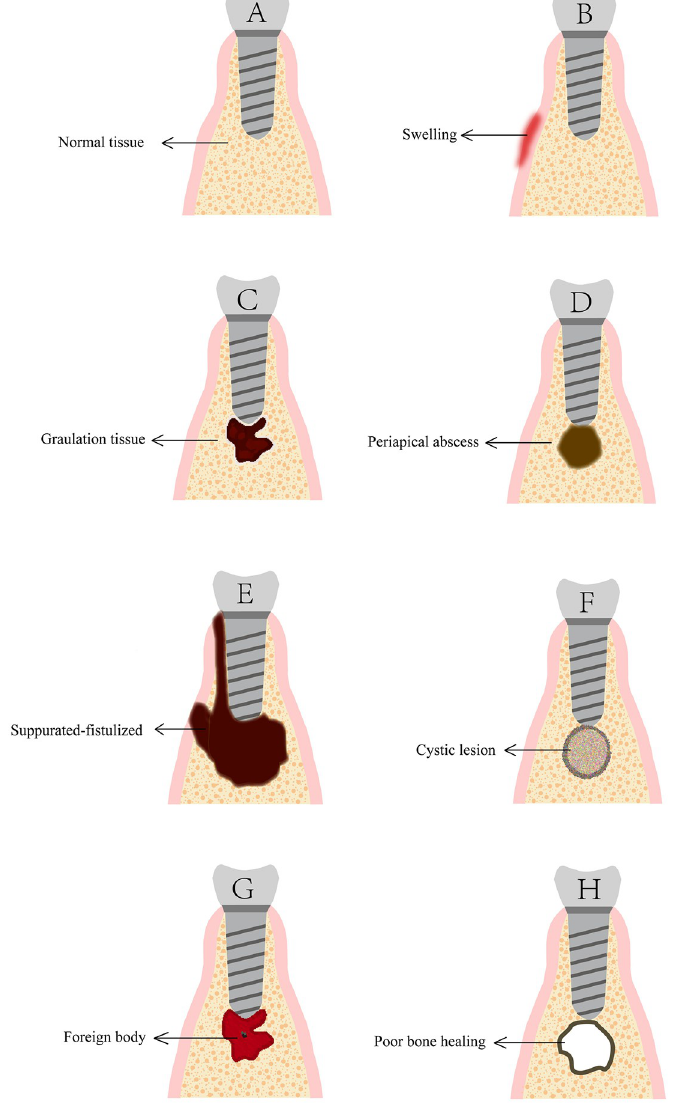
Fig 2. Schematic representation of each category of histological IPL classification. A: Normal implant periapical status; B: Acute non-suppurative stage (no radiological changes); C: Chronic granulomatous stage; D: Acute suppurative stage (pus formation); E: Chronic suppurative fistula (two-drainage pathways); F: Implant periapical cyst. G: Foreign body reaction (radiologically visible or invisible); H: Poor bone healing.